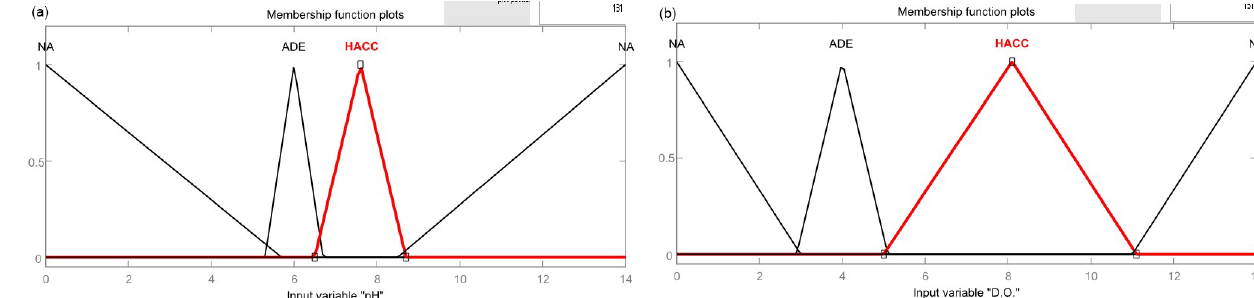
Figure 2. Membership function plot (a) pH and (b) dissolved oxygen.